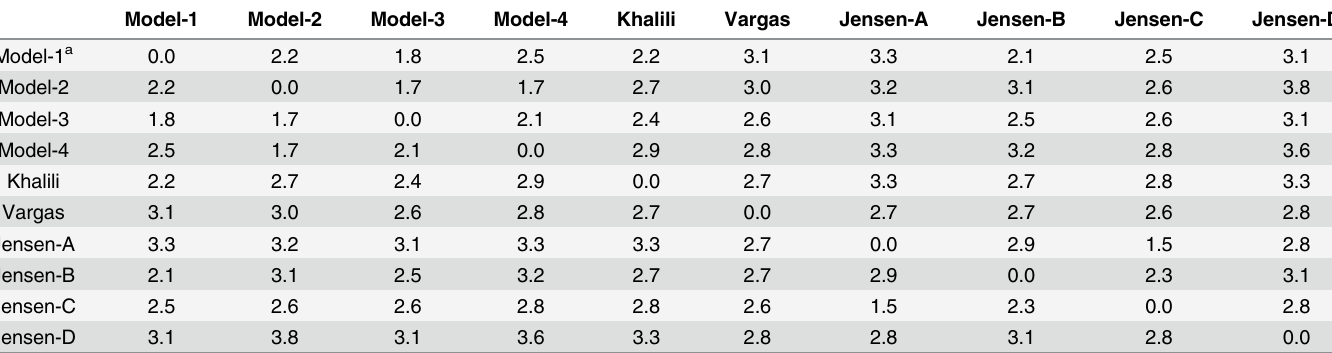
Table 3. The backbone RMSD values of the TM helices S1 – S4 between different models.